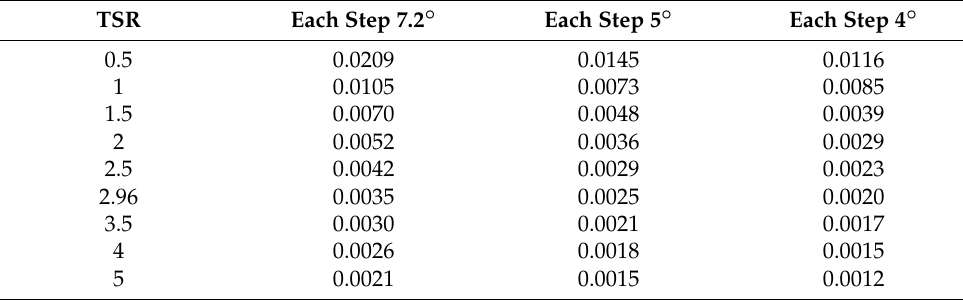
Table 4. Different blade tip speed ratio corresponds to the time step of each